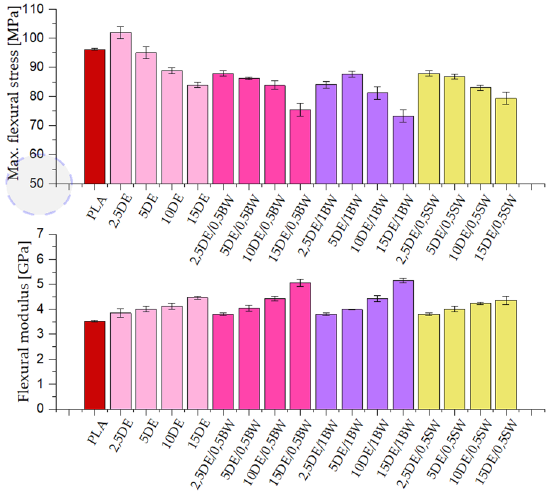
Figure 8. Maximum flexural stress and flexural modulus for samples conditioned at room temperature.